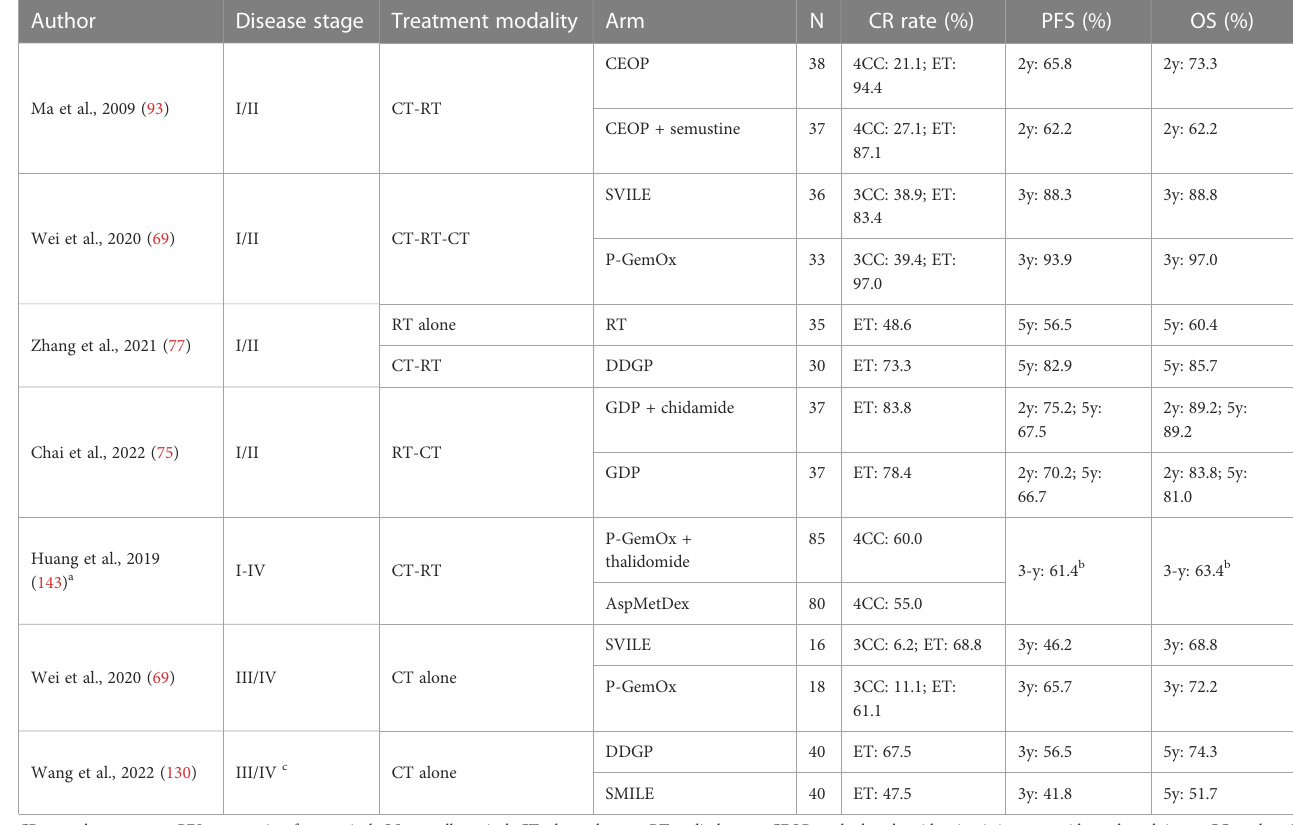
TABLE 2 Prospective randomized controlled studies in